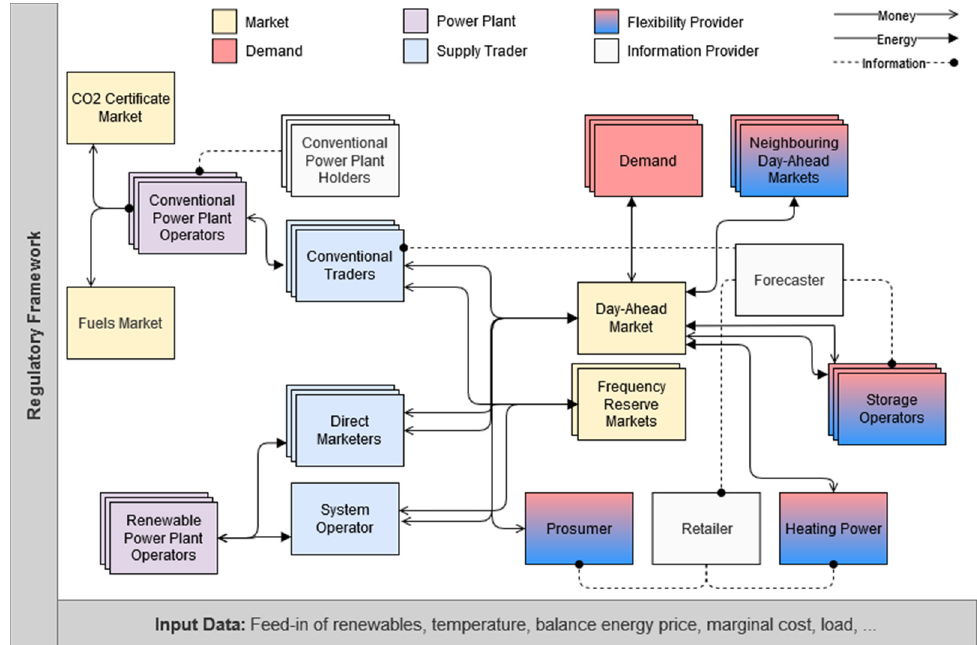
Figure A1. AMIRIS model scheme.